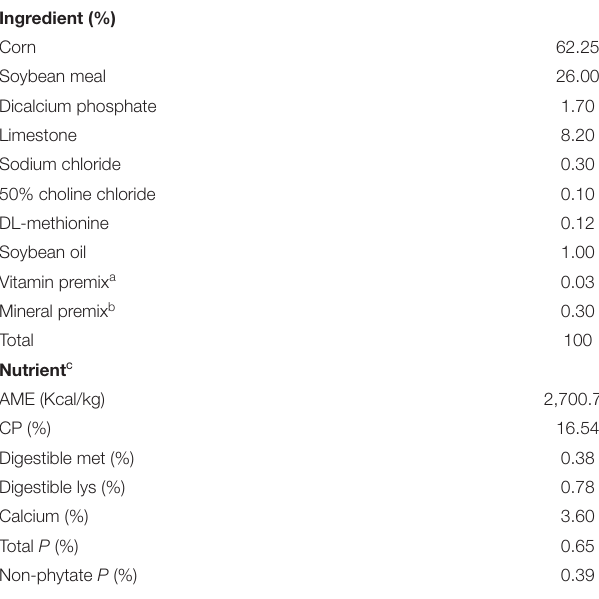
TABLE 1 | Composition and nutrient levels of basal diet (as-fed basis).